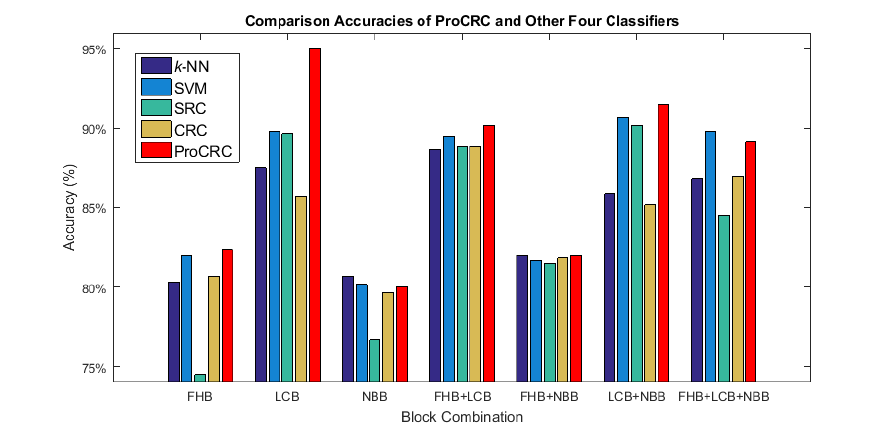
Figure 17. Comparison results of the ProCRC and the four